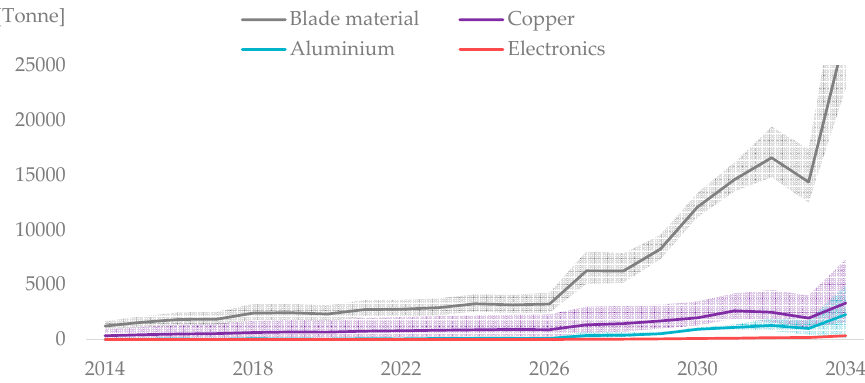
Figure 7. Estimated waste amounts of blade material-, copper-, aluminium-, and electronic generated from the Swedish wind power industry between 2014 and 2034. The solid line is the result of using the mean material specification and the area shows the range between applying the minimum and maximum values found. Table 2. Estimated waste from wind power plants in 2024 and 2034 and total recycled amount of material in Sweden 2014 [68,69]. Percentages of estimated generated waste compared to total recycled amounts in 2014 are shown in